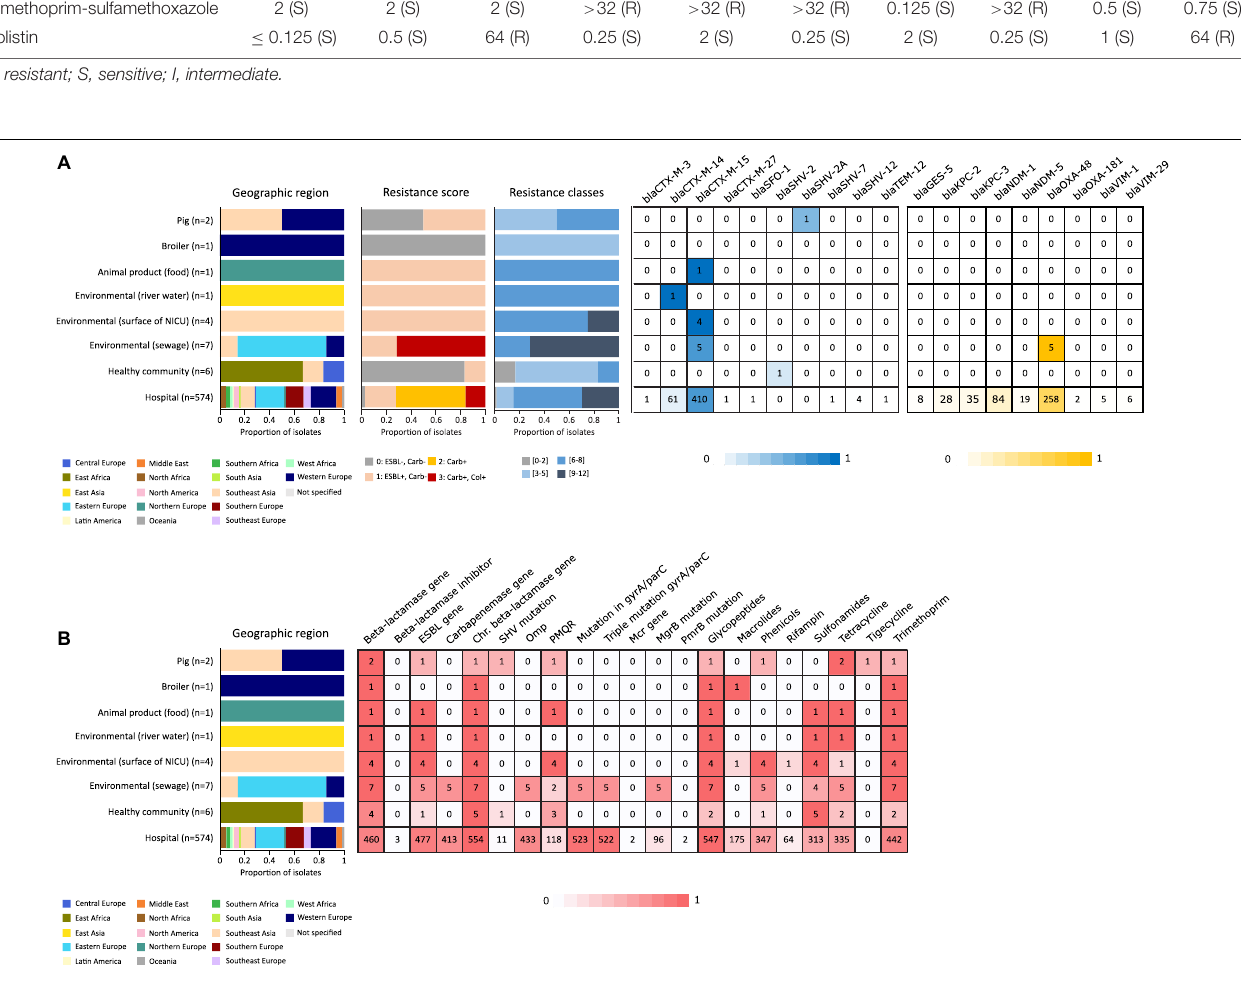
FIGURE 1 | Resistance originating from ESBL- and carbapenemase production (A) and resistance to different antibiotic classes (B) detected in an international collection of hospital-associated, livestock-associated, healthy community and environmental K. pneumoniae ST101. Graphs and heatmaps show the proportion of isolates, numbers in the heatmaps indicate the number of genomes containing the resistance